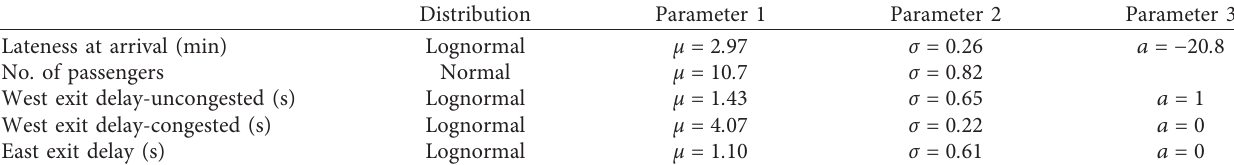
Table 1: The probability distributions used in the case study and their parameter